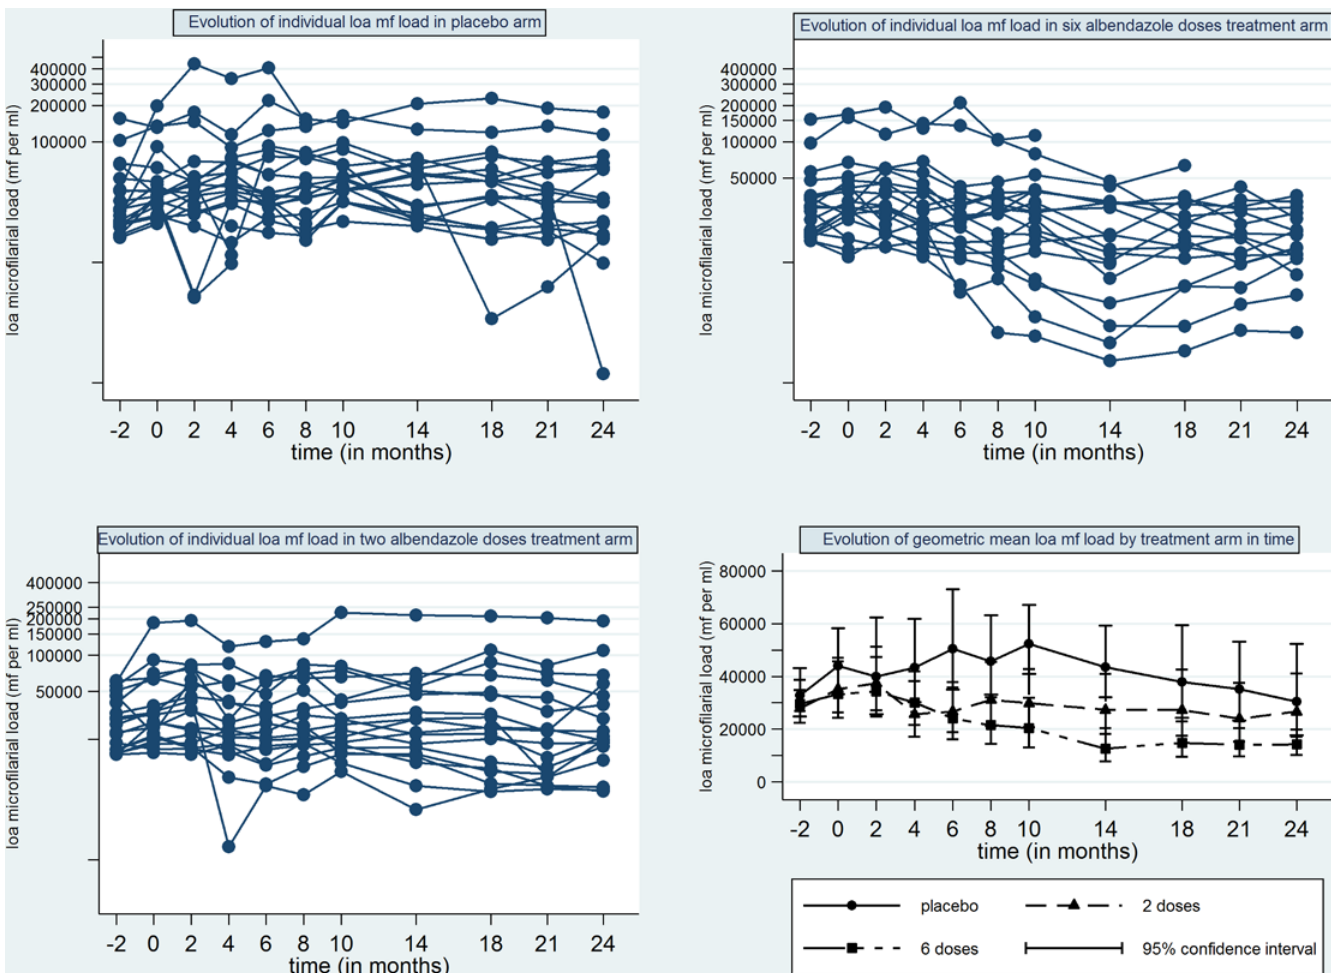
Fig 2. Loa loa microfilaraemia in individual participants by treatment group and geometric means of microfilaraemia by treatment group. mf per ml: microfilaria per millilitre of